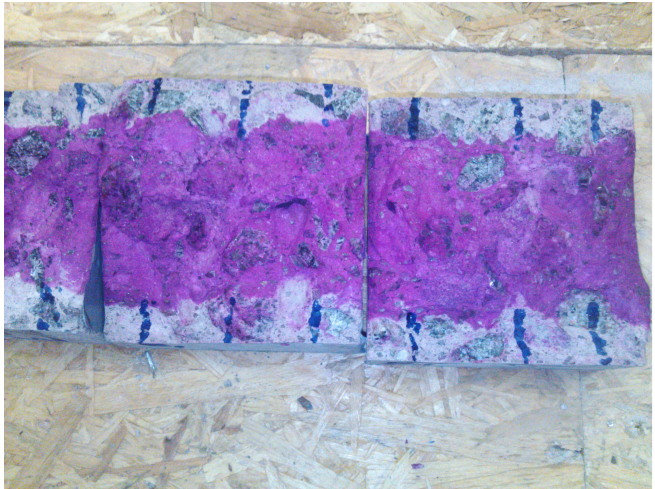
Figure 9. Samples after carbonation.